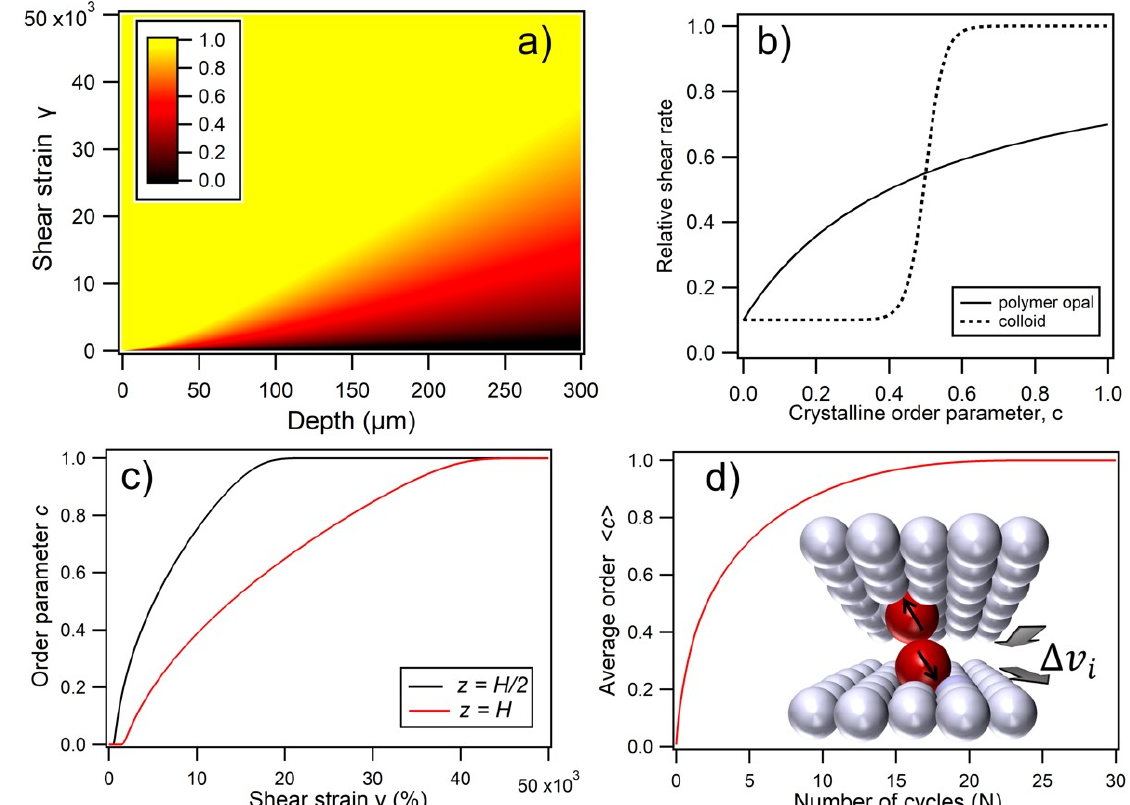
Figure 4. ( a ) Simulated nonlinear diffusion of crystal order into a sample with increasing total applied strain, showing a grad- ual depth transition which replicates experimental observations. The simulation parameters were strain amplitude = 150%, frequency = 1 Hz, and a z-scale for the ordering parameter, c, is shown as an inset. The nonlinear transfer relations between the normalized shear rate and crystalline order in each layer, f ( c ), used in simulations are plotted in ( b ), comparing the intuitive two-phase model for a colloid, with the polymer opal as indicated. ( c ) Shows how the order parameter varies at the cell midpoint (z = H/2) and full depth (H) as a function of total applied strain. ( d ) Shows how the order parameter, as spatially averaged across the 300 µ m width of the sample, varies as a function of the number of BIOS oscillations (N). The inset schematic illustrates the assumed mechanism of ordering forces for individual errant spheres, where there is a relative layer velocity of ∆ ν i